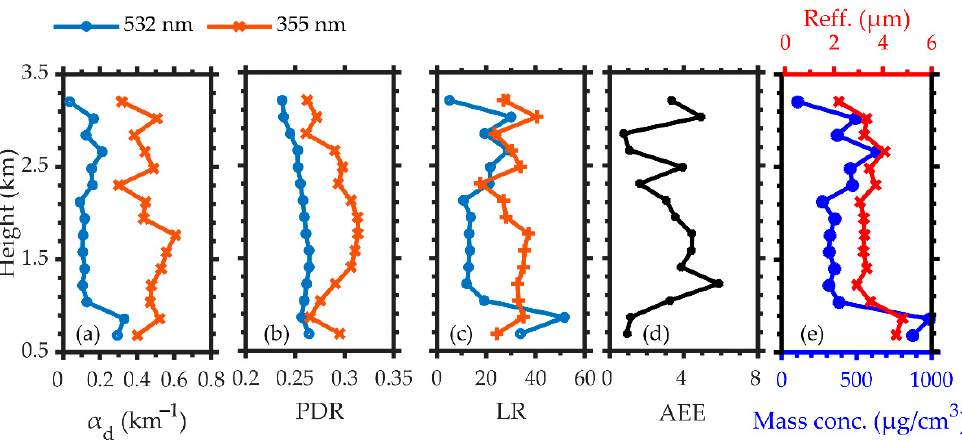
Figure 7. Case 2: lidar-derived parameters on 7 July 2019, between 00:00 and 06:58 CST. ( a ) α d , ( b ) PDR, ( c ) LR, ( d ) AEE 532,355 , and ( e ) dust mass concentration ( µ g cm − 3 ) and effective radius of dust ( µ